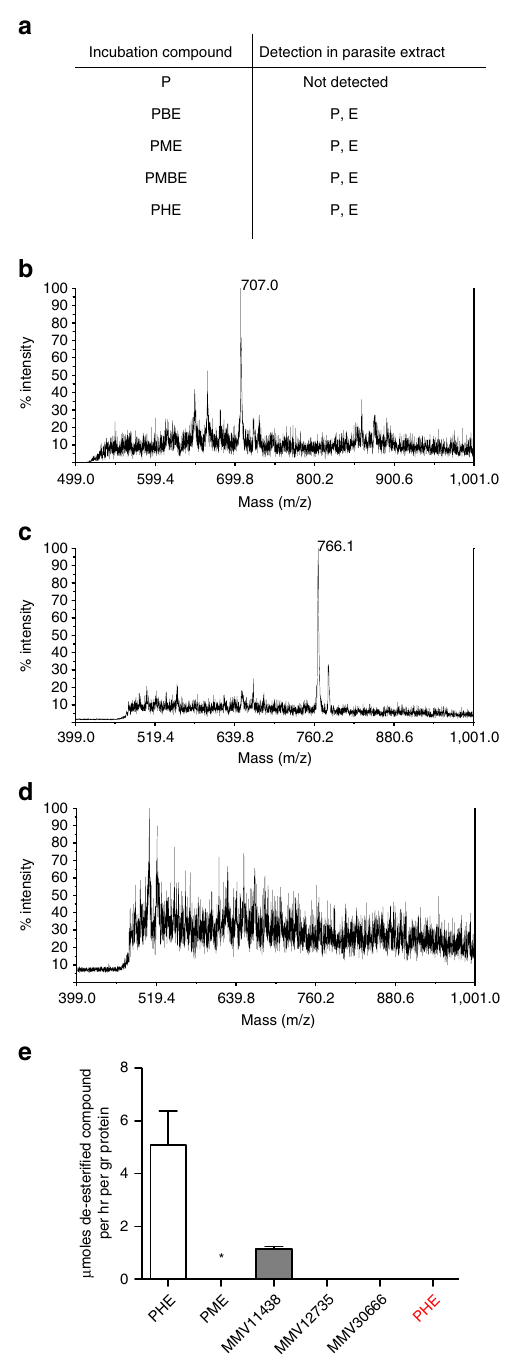
Figure 3 | In cell metabolism of pepstatin esters. ( a ) Detection of pepstatin (P) or pepstatin esters (E) by MALDI-TOF. Fractions of 3D7 lysates after incubation with pepstatin (P) or analogues were spotted onto a MALDI plate and scored for the presence or absence of compounds with appropriate mass. This MS assay is not quantitative. ( b – d ) MALDI-TOF spectra of HPLC fractions (C18) from whole cells extracts of 3D7 ( b ) or S179T mutant parasite ( c , d ) infected RBCs, incubated with PBE. The dominant peak of 707.0 ( b ) corresponds to the Na-adduct of pepstatin. The dominant peak of 766.1 ( c ) corresponds to the Na adduct of PBE. Pepstatin was never detected in any fractions prepared from S179T mutant parasite extracts ( d ). ( e ) Activity of recombinant PfPARE on pepstatin esters and MDTIP compounds 16 . Wild-type or mutant proteins were incubated with compounds and amounts of de-esterified products were determined by LC/ MS (triplicate reactions). Results for incubations with wild-type enzyme are in black, with S179G mutant enzyme is in red. *Pepstatin from incubations with PM could be detected by MALDI-TOF, but not significantly by LC/MS. Error bars are